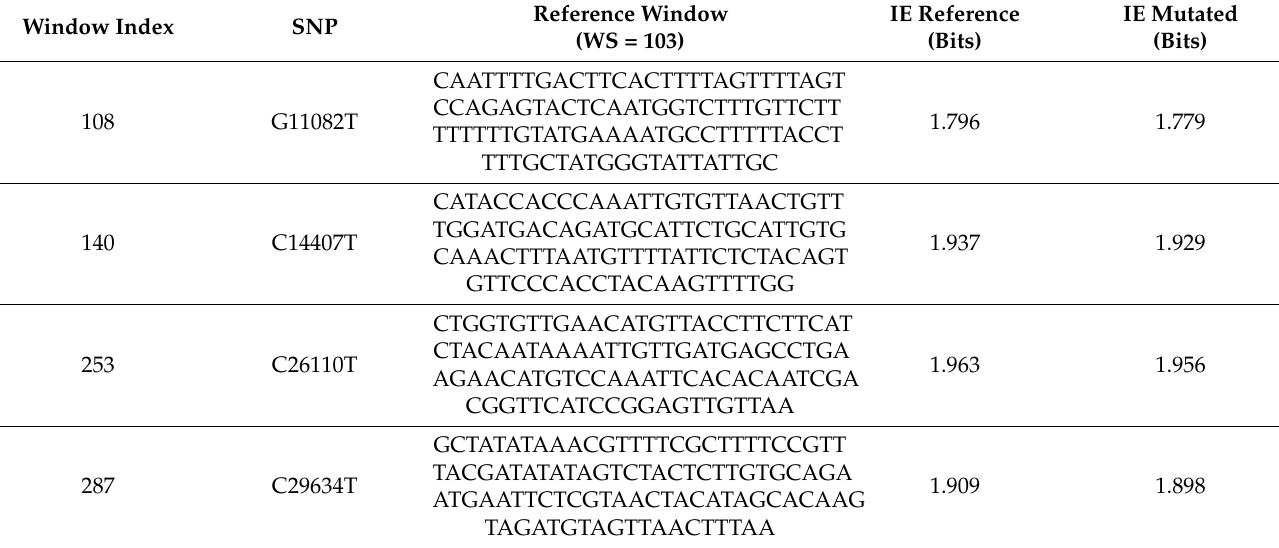
Table 2. Details of the mutations that occurred in SARS-CoV-2 reference genome (MN908947) to result in the first mutated variant (LC542809), including the IE values of their corresponding windows where the mutations took